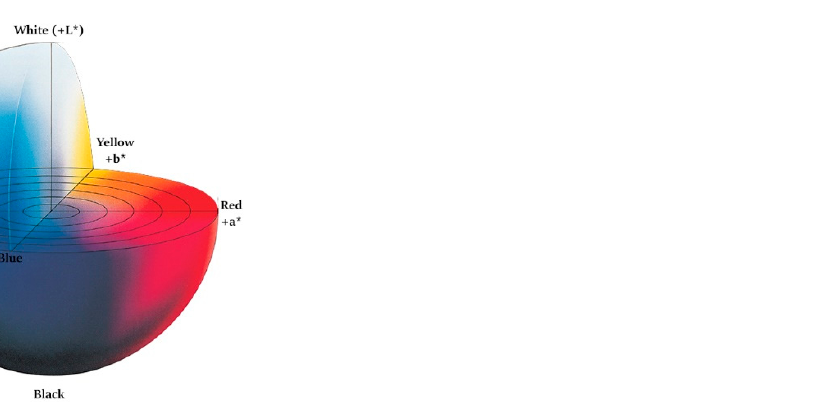
Figure 11. Schematic of the colour spectrum L, a, b of the CIELab system [31] (Photo courtesy of Konica Minolta, Inc. All rights reserved.).